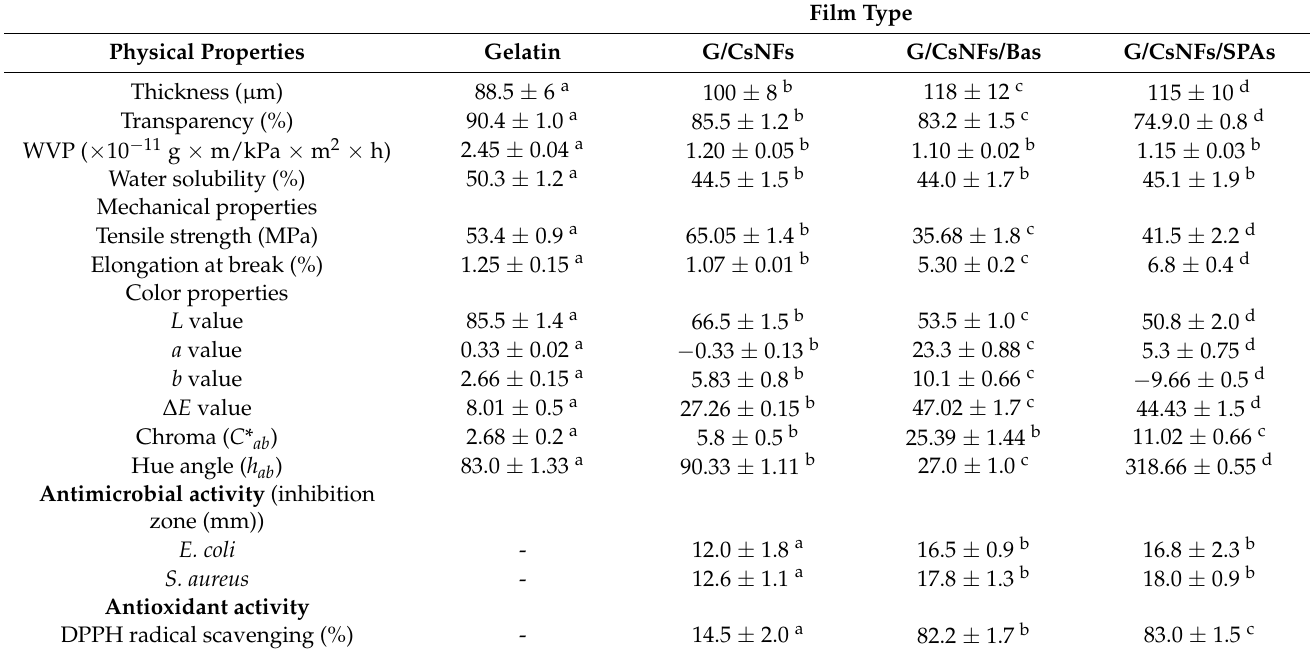
Table 1. Characteristics of biocomposite films loaded with barberry and saffron